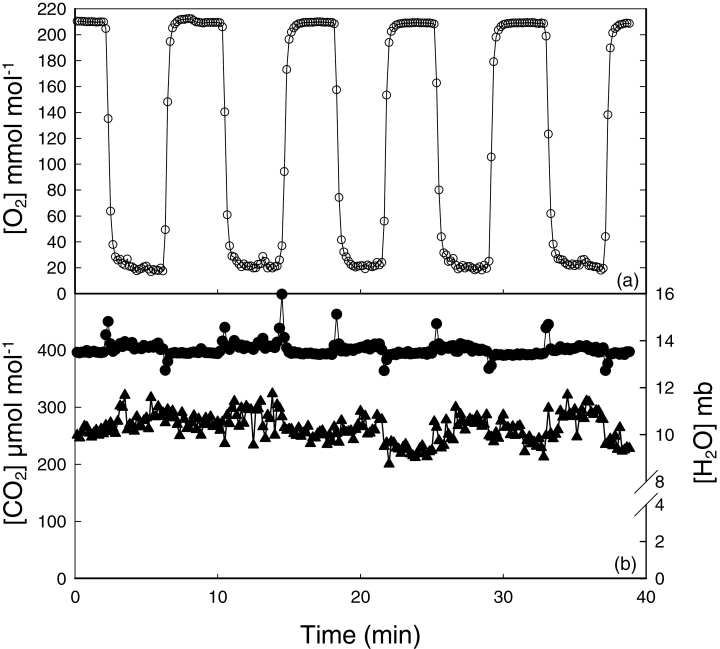
Concentrations of (a) O2 and (b) CO2 (filled circles) and water vapour (triangles) in the measuring chamber during an experiment. Oxygen concentration was switched from atmospheric (210 mmol mol–1) to 20 mmol mol–1 five times while maintaining CO2 and H2O vapour concentrations.